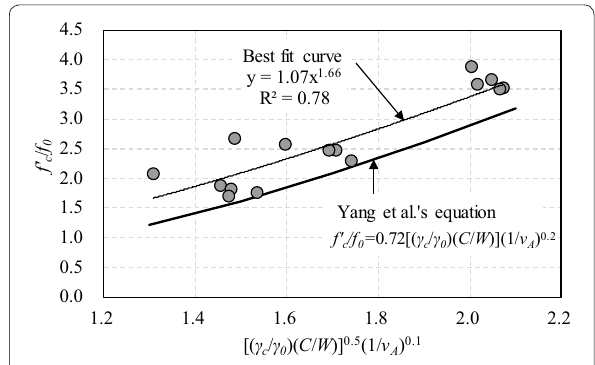
Fig. 5 Regression analysis for the 28‑day compressive strength of the